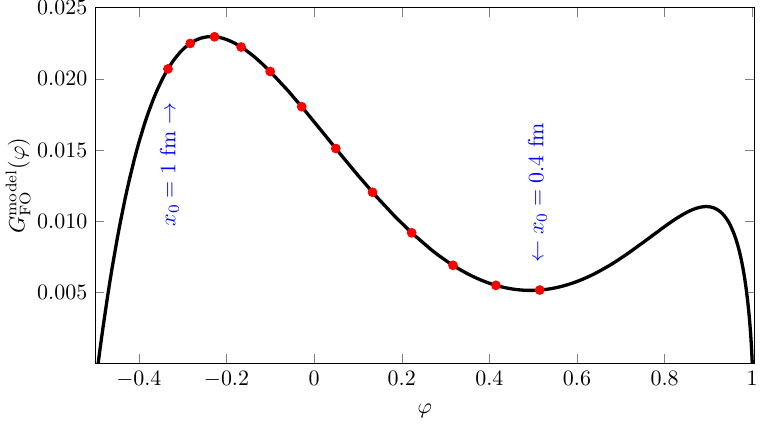
( ϕ ) function in the interval − 0 . 5 ≤ ϕ ≤ 1 FO